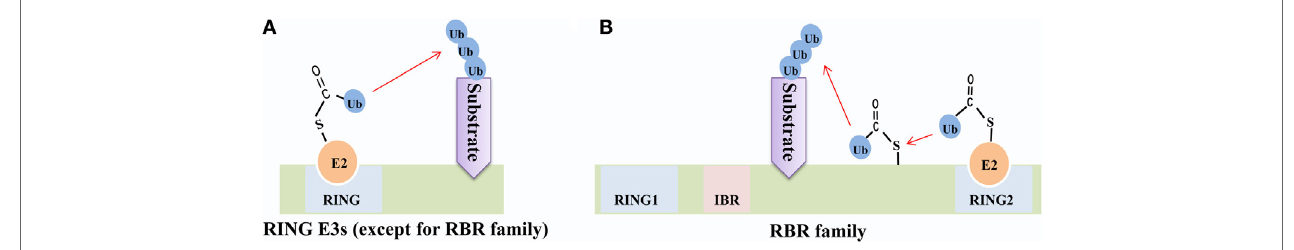
FiGURe 3 | Mechanisms of ubiquitin (Ub) transfer by RING-domain E3 ligases (RING E3s). (A) Most RING E3s [except for the RING between RING (RBR) family] employ the classical mechanism that transfers Ub from E2-Ub directly to the substrate. (B) The RBR E3s’ N-terminal RING domain (RING1) employs the classical mechanism to facilitate ubiquitination of the substrate, while C-terminal RING domain (RING2) transfers Ub from E2-Ub to generate an E3-Ub intermediate and then transfers Ub to the